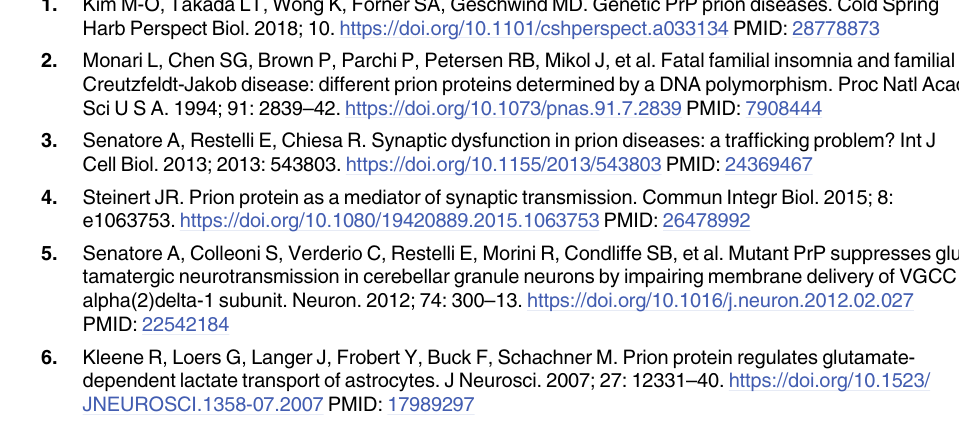
recover for five minutes and stimulated with AMPA again. Data are the mean ± SEM of 25 cells from three fields. AMPA, 0.39 ± 0.05; AMPA+IEM, 0.12 ± 0.02; ���� p < 0.0001 by two- tailed, Wilcoxon matched-pairs signed rank test. S5 Fig. AMPA induces apoptosis in cerebellar granule neurons. (A) Cultures of cerebellar granule neurons from C57BL/6J mice were exposed to 300 μ M AMPA for 24h. Cells were fixed and subjected to TUNEL staining (DeadEnd Fluorometric TUNEL System, Promega), then reacted with Hoechst 33258 to stain cell nuclei. Scale bar 100 μ m. (B) TUNEL-positive cells were counted and expressed as percentages of the total cells identified with Hoechst 33258. CT, 0.67%; AMPA,